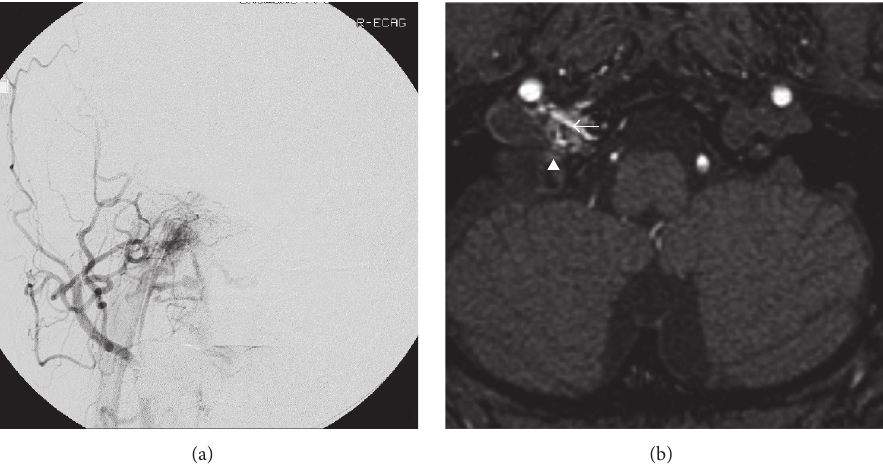
Figure 1: Right external carotid angiogram depicting dural arteriovenous fistula. It is fed by ascending pharyngeal artery and it drains to the vertebral venous plexus (a). Axial source image of time-of-flight MRA shows hyperintense thin vessel penetrating hypoglossal canal (arrow) and arterialized venous pouch of right anterior condylar confluence (arrowhead).